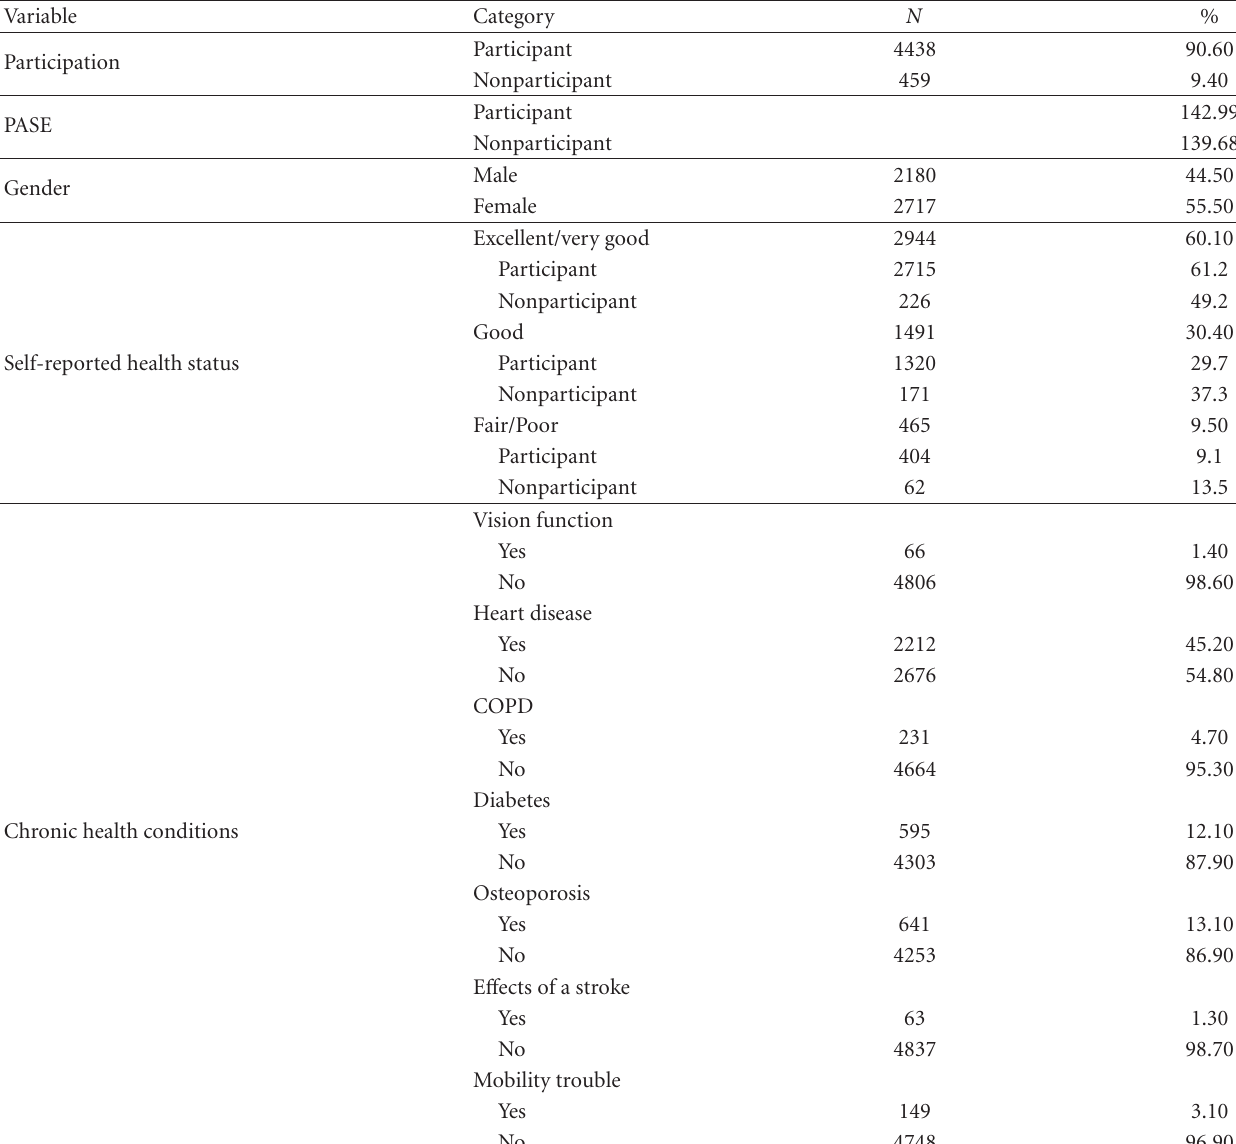
Table 1: Sample descriptive statistics (weighted